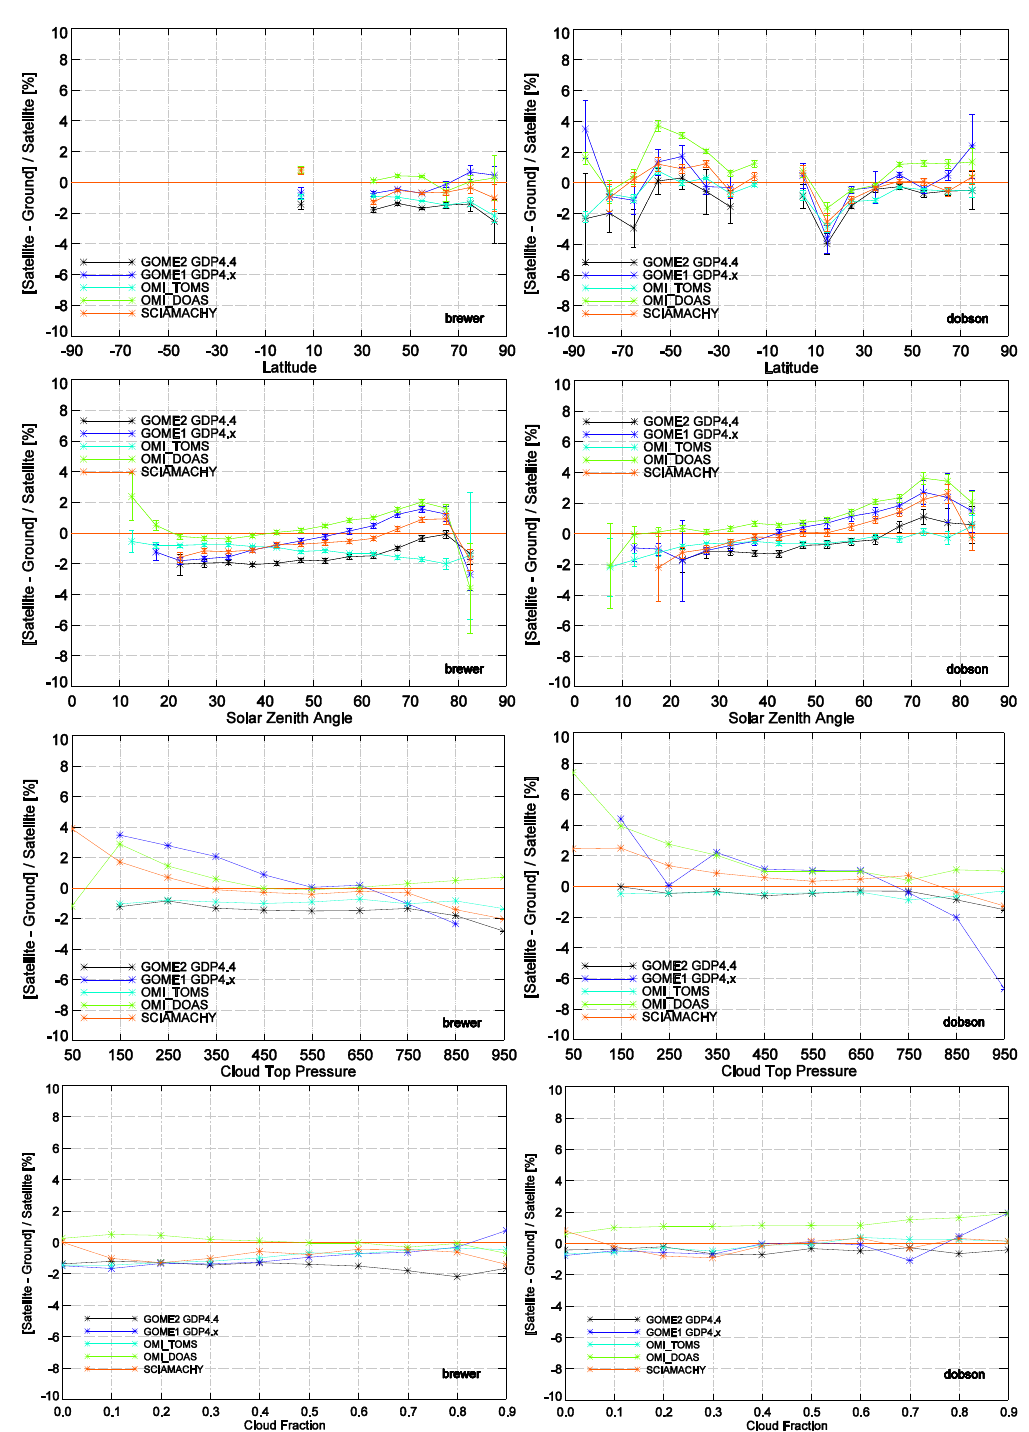
Fig. 4. Comparisons of GOME-2 (black), GOME-1 [dark blue], OMI-TOMS (light blue), OMI-DOAS (light green) and SCIAMACHY (orange) total ozone against the same ground-based measurements. Left column are the Brewer comparisons and the right column the Dobson comparisons. From top to bottom, the dependence of the percentage differences as function of latitude, solar zenith angle, cloud top pressure and cloud